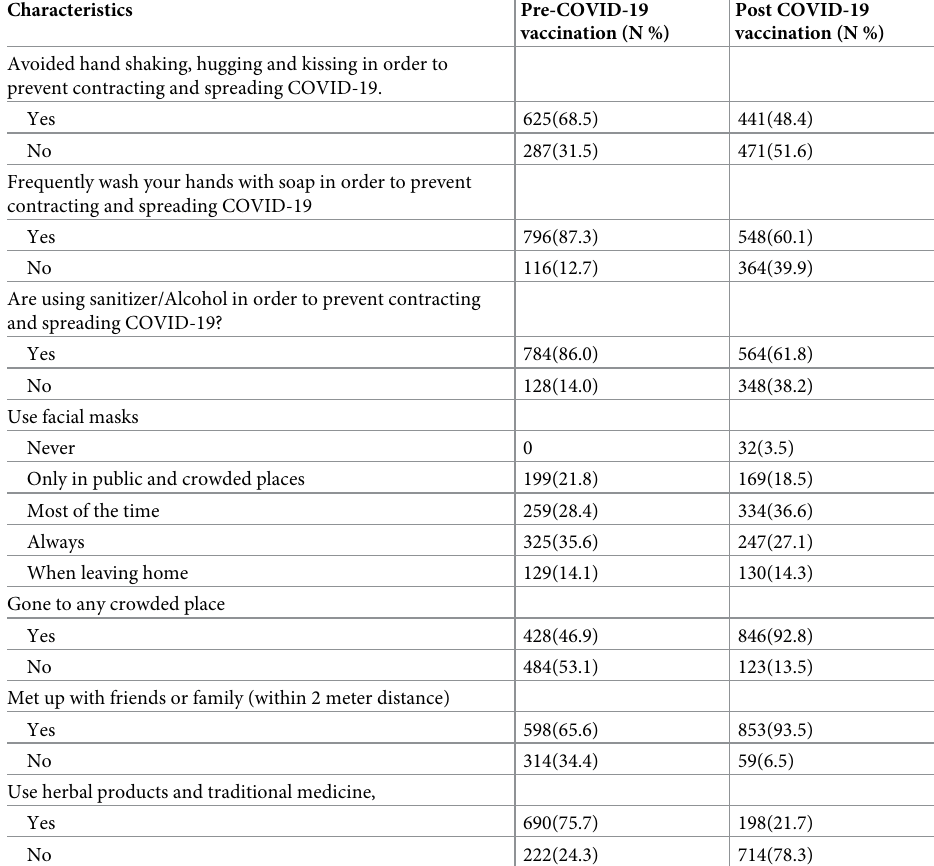
Table 1. Respondents practice to protect COVID-19 infections pre and post COVID-19 vaccination for the study of post COVID-19 vaccine evaluations in Oromia region, Ethiopia, 2021.